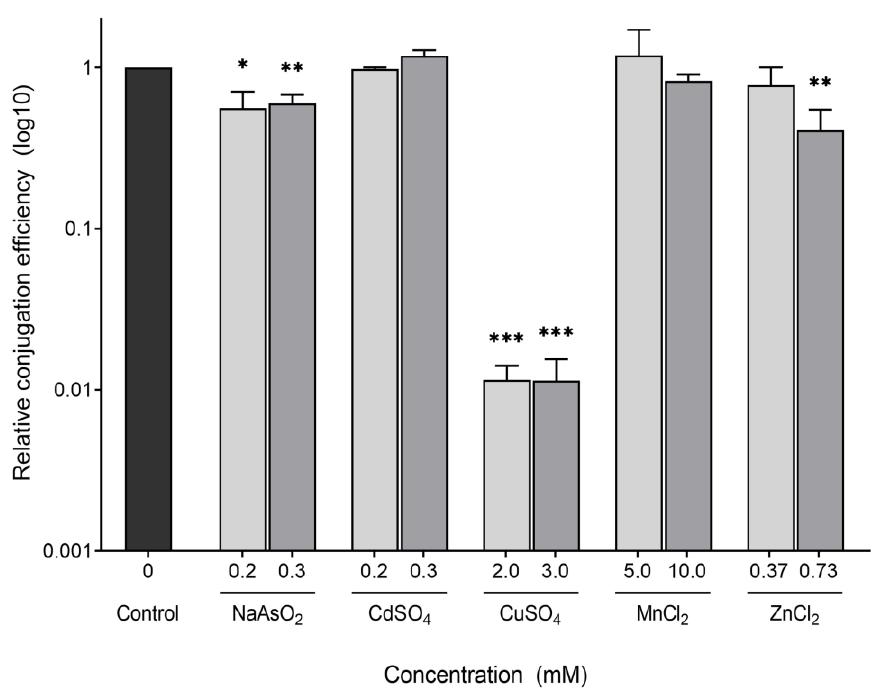
Figure 1. Effect of heavy metals on conjugation efficiency of an F-plasmid in E. coli . Donor and recipient strains were grown to log phase and then allowed to mate in the presence of heavy metals at the indicated concentrations. Conjugation efficiency is expressed as the ratio of transconjugants formed per donor. Bars represent the mean conjugation efficiency relative to the control (no heavy metal added), and the error bars are the standard error of the mean (SEM) of 2 – 6 biological replicates with 2 technical replicates each. p -values were computed using a one-sample unpaired t-test comparing the sample mean to a hypothetical value of 1 (the mean relative conjugation efficiency of the control). The level of significance is indicated as follows: * p < 0.05, ** p < 0.01, *** p < 0.001.